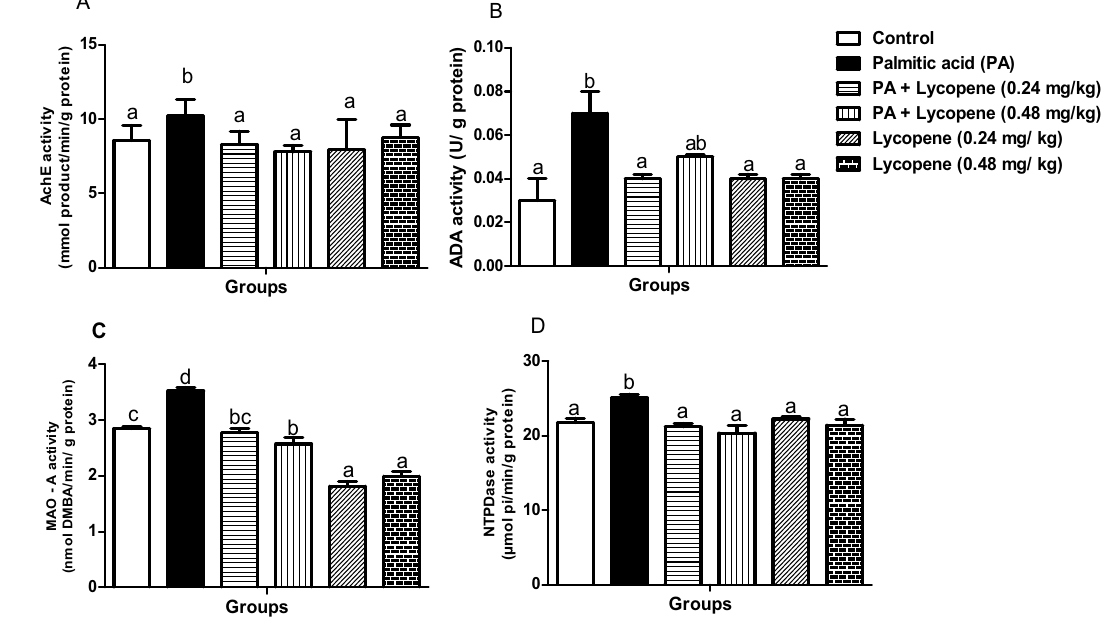
Figure 1. Effects of lycopene on the activities of neuro-behavioural marker enzymes of palmitic acid-induced neuro-inflammation in female rats. Values are expressed as mean ± S.E.M (n = 5). Bars with different letters are statistically distinct (p < 0.05). ( A ) AchE – acetylcholine esterase ( B ) ADA- adenosine deaminase ( C ) MAO-A- monoamine oxidase- A, (D) NTPDase – nucleotide triphosphatidase. Data were analysed using SPSS version 20 (IBM SPSS Software, United Kingdom) while the graph was plotted using GraphPad Prism Software, version 6 (San Diego, CA 92,108) https:// www. graph pad. com/ scien tific- softw are/